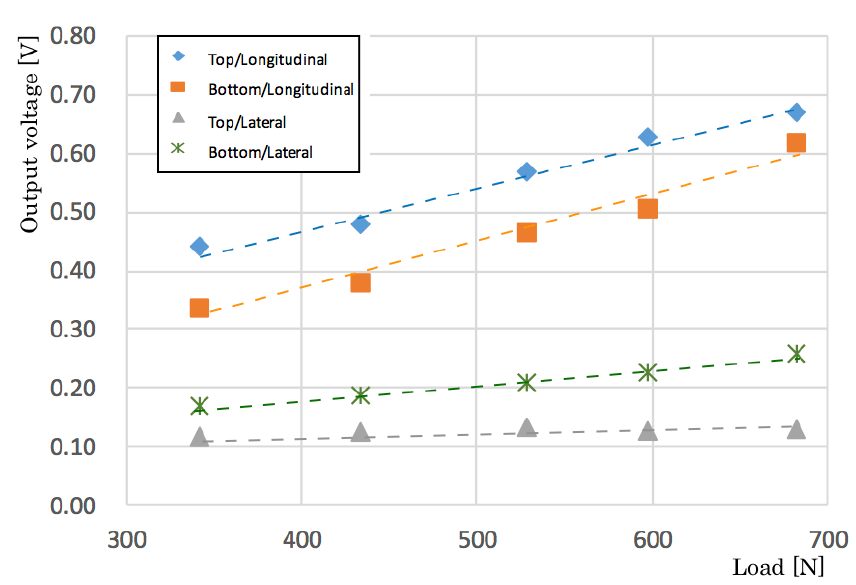
Figure 7. Relation between output voltage and load of side and orientation.